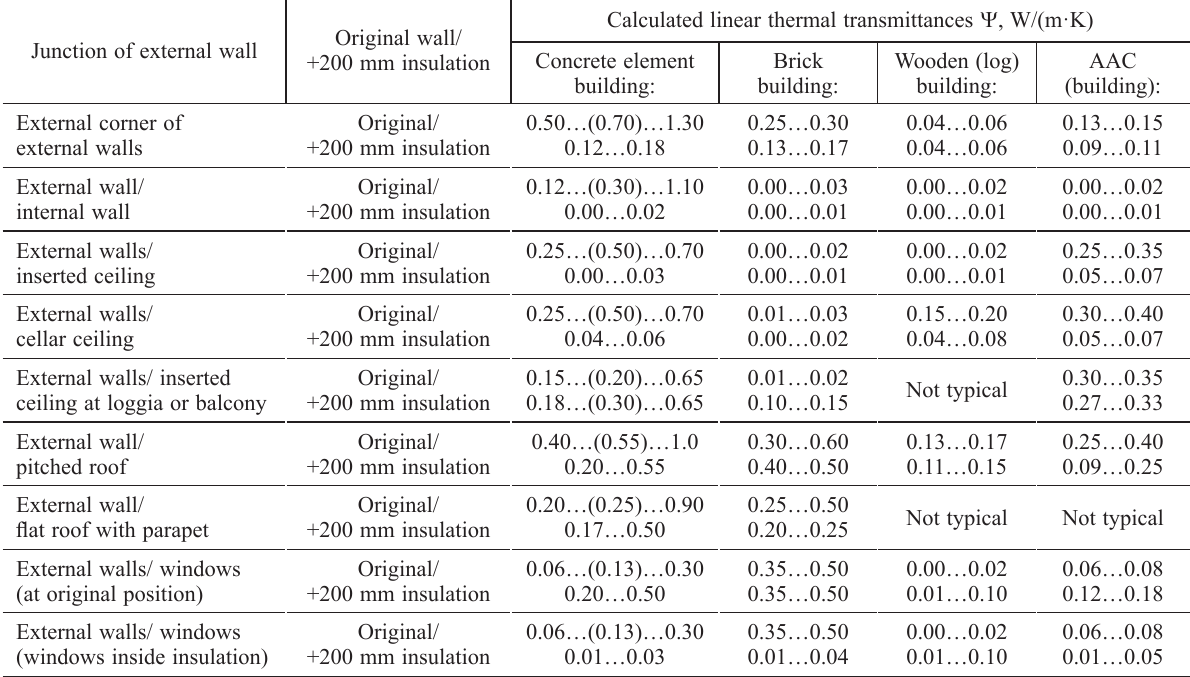
an external wall/inserted ceiling at balcony is shown in Figure 6. At a wide range of values (e.g. concrete element buildings), also the third number in between is proposed, which can be considered as the most probable. Without any information available, that value can be used in the energy audit as the first approximation. At the external wall/roof junction both or only one can be insulated.